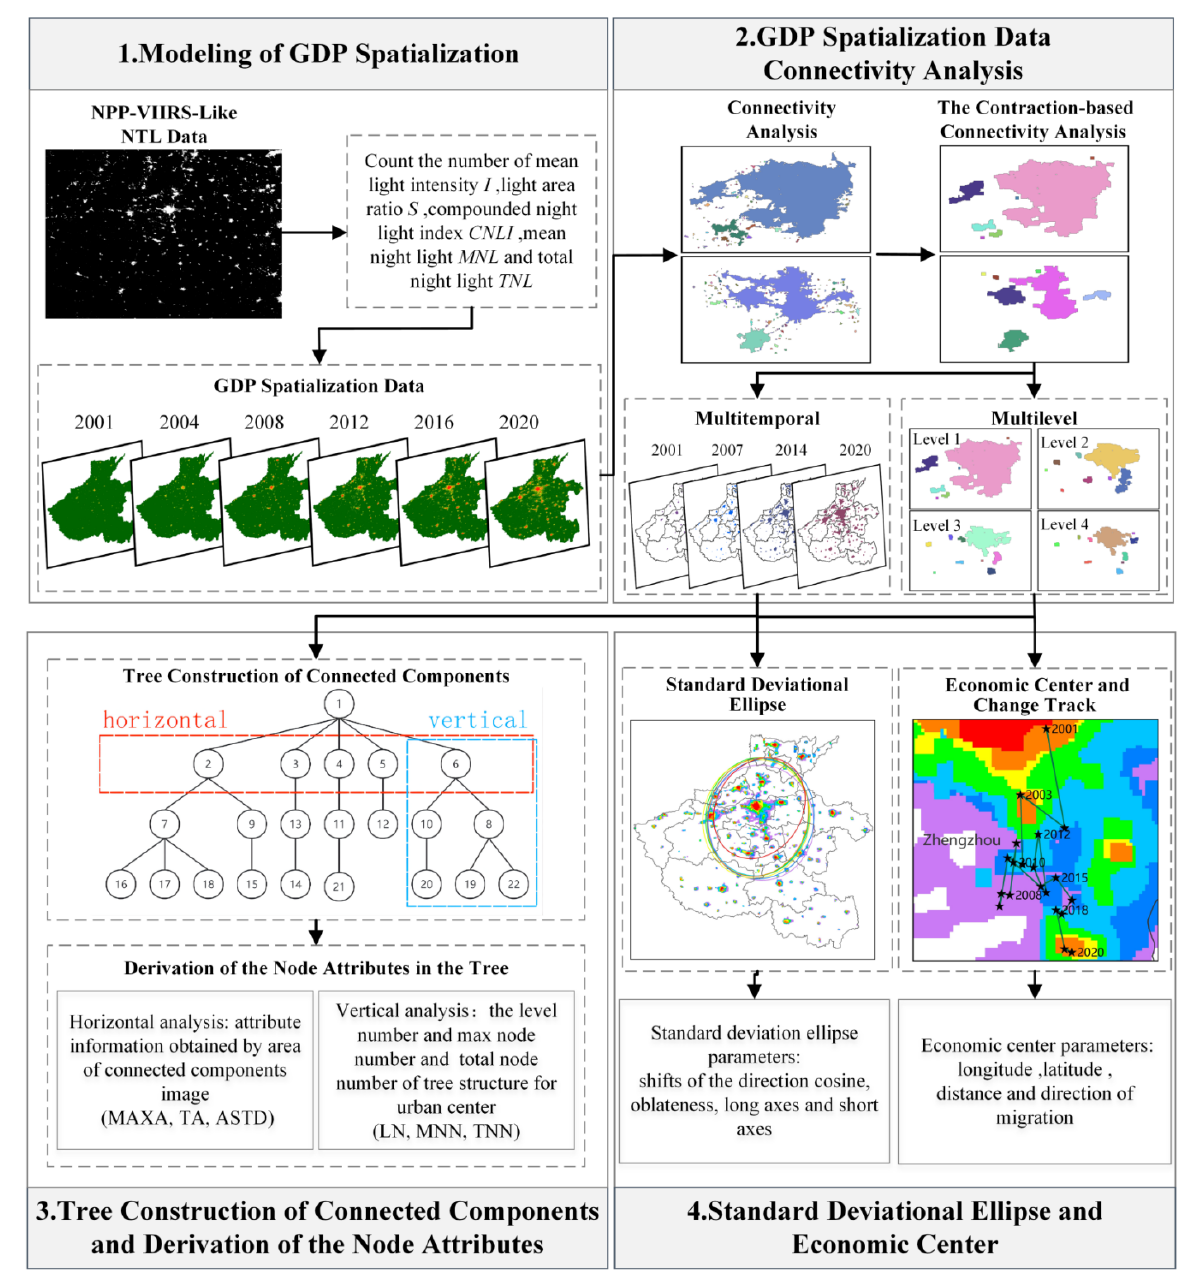
Figure 4. Technical flow chart of the study: (1) modeling GDP spatialization; (2) GDP spatialization data connectivity analyses; (3) tree construction of connected components and derivation of the node attributes; (4) standard deviation ellipse and economic center.